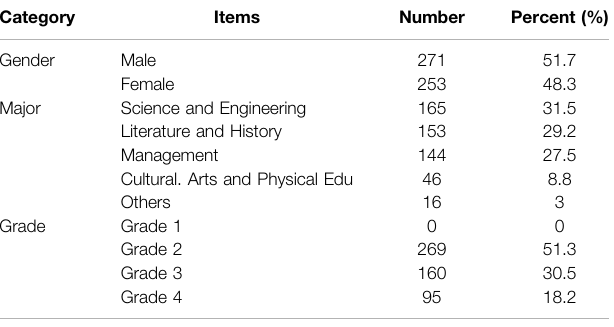
TABLE 4 | Cronbach ’ s ɑ coef fi cient of each